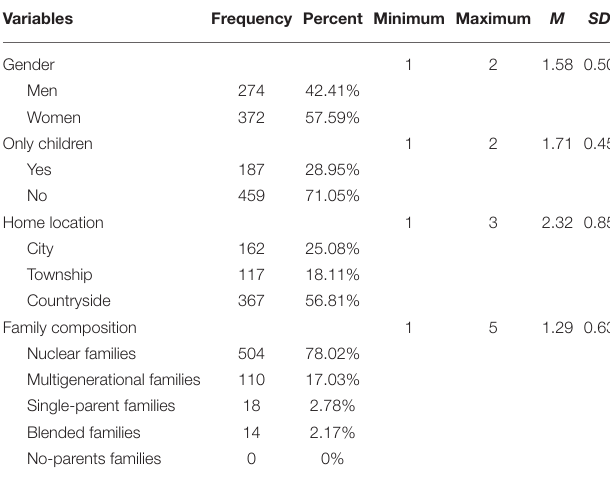
TABLE 1 | Demographic characteristics